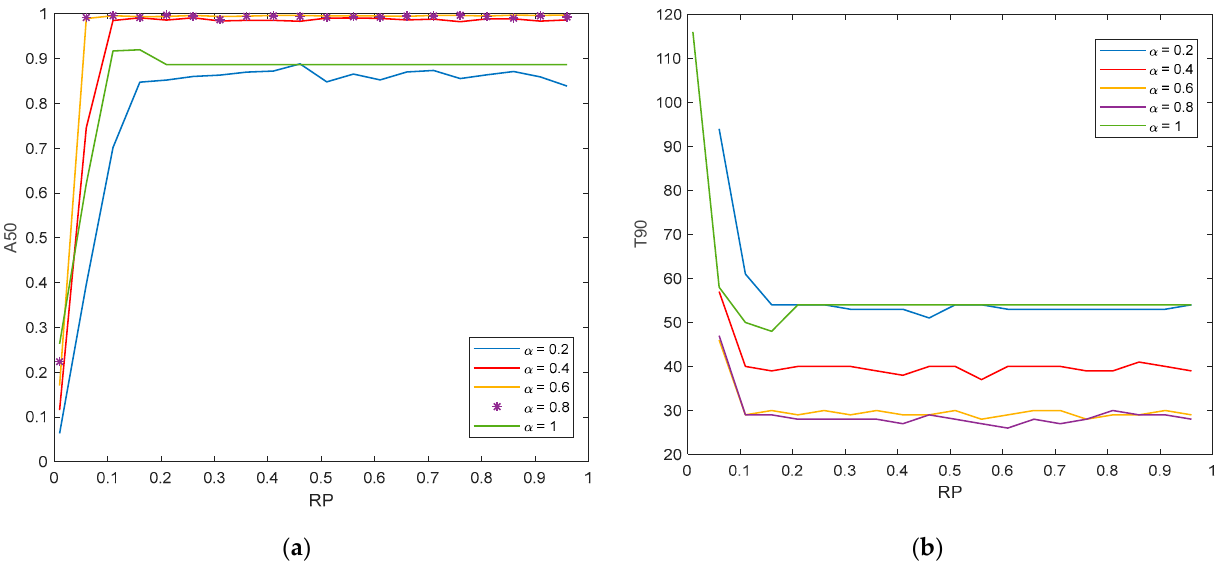
Figure 9. The results of ( a ) recovery levels at time step 50, P = 0.01, and ( b ) 90% recovery time, P = 0.01, under load-based cascading failures with different certainty levels and various recovery potentials in the Minnesota road network.